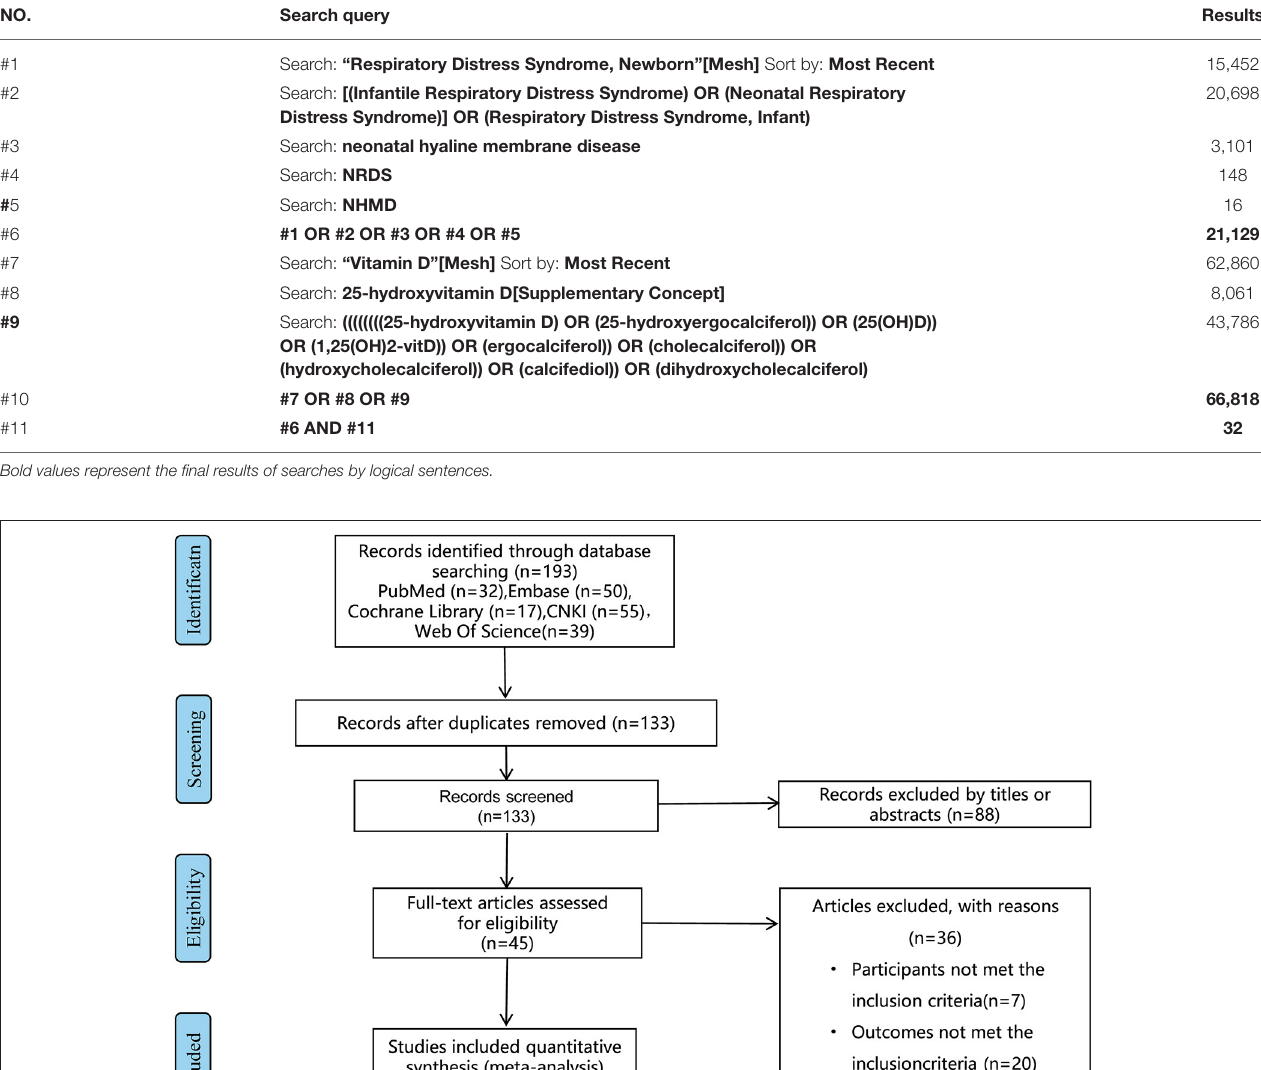
TABLE 1 | Search strategy for PubMed.